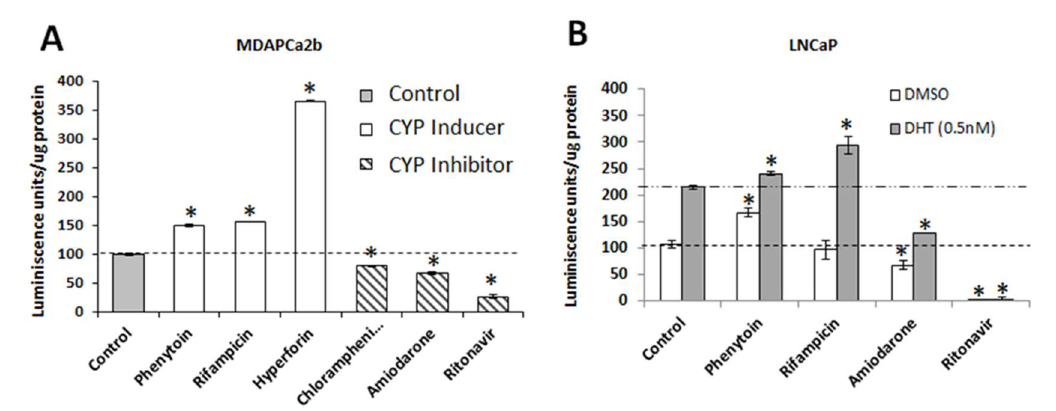
Figure 6. Reporter assay showing effect of CYP3A5 inhibitor/inducer treatment on AR downstream signaling. ( A , B ) MDAPCa2b and LNCaP cells transfected with androgen response elements (ARE) fused to luciferase were used to evaluate AR downstream signaling activity. MDAPCa2b cells were treated with known CYP3A5 inducers (Phenytoin-50 µM, hyperforin-200 g/mL, and Rifampicin-30 µg/mL) and inhibitors (Ritonavir-35 µM, Azamulin-10 µM, chloramphenicol-10 µM, and Amiodarone-5 µM). LNCaP cells were treated with CYP inducing and inhibiting drugs in charcoal stripped serum followed by DHT (0.5 nM) induction for one hour. In both cases, CYP3A inducers showed increased AR signaling activity whereas CYP3A inhibitors showed decreased AR signaling activity. * p ≤ 0.05.